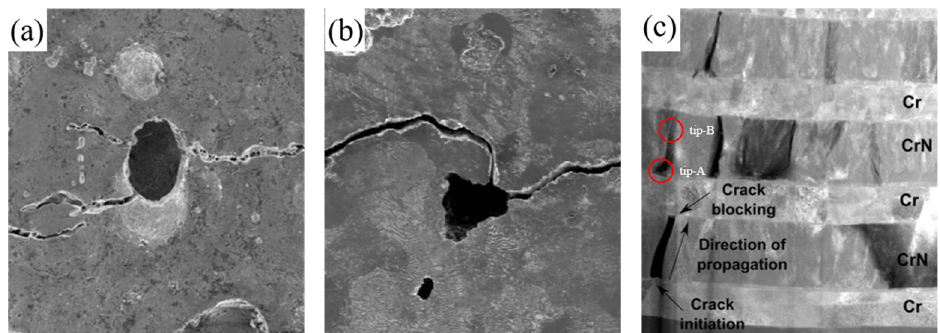
Figure 1. Micro-defects revealed by scanning electron microscopy (SEM) images ( a ) Reprinted with permission from Ref. [1]. 2021 The Royal Society, ( b ) Reprinted from Ref. [2], ( c ) Reprinted with permission from Ref. [4]. 2021 Elvesier.